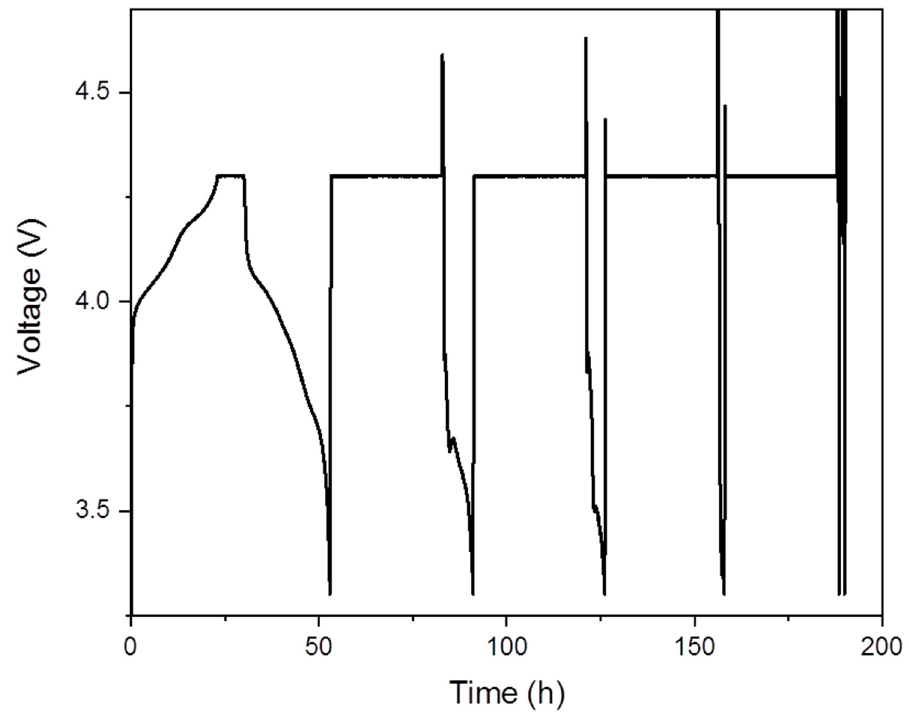
Figure 3. Voltage profile of in-situ windowed coin cell cycled at C/20 in constant current-constant voltage mode.